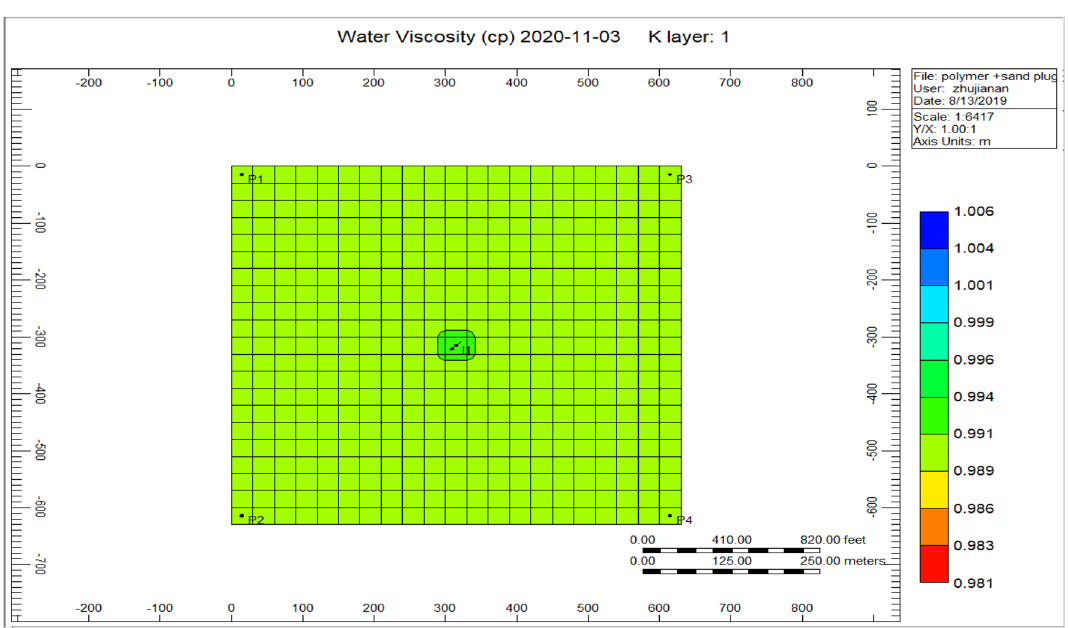
Figure 14. Shows the water viscosity of the cross-linked gel achievement model CMG STARS 2017.10 URL: https:// www. cmgl.